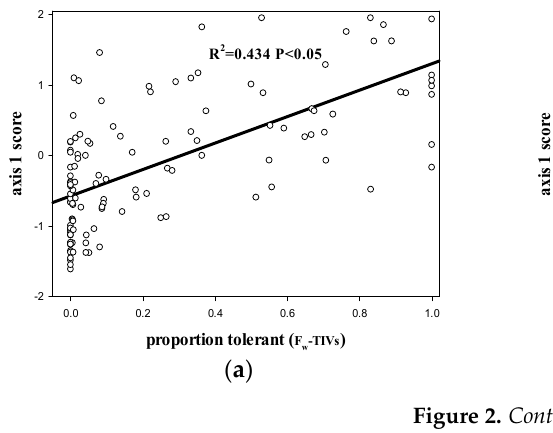
Table 1. Eigenvector matrix for principal component analysis (bold values are considered high